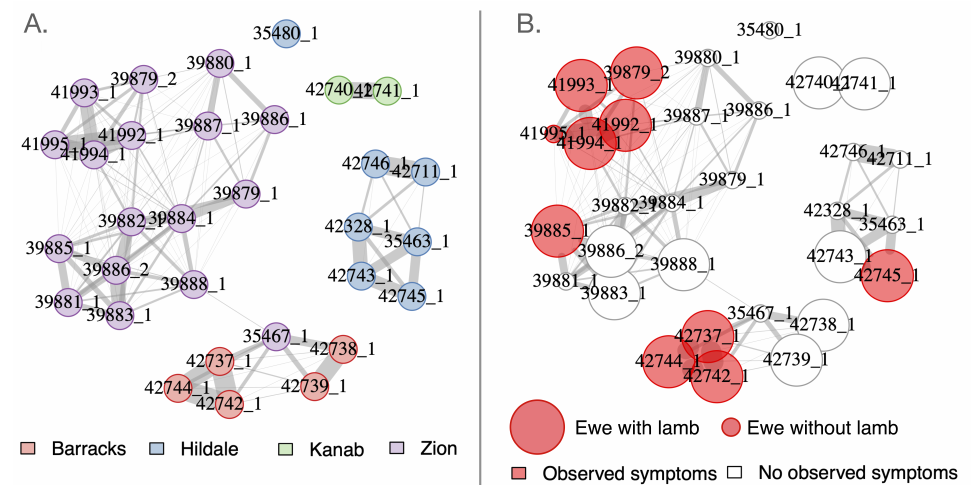
Figure 6. Ewe association network during the 2019 field study. The graph’s layout was determined using a Fruchterman–Reingold graph projection, which pulls nodes toward one another in proportion to the strength of association between the two individuals involved. ( A ) Social network with animal nodes colored according to their original release areas (“Zion” = within ZNP). ( B ) Social network with animal nodes colored according to whether or not they were observed in a group displaying pneumonia symptoms (red indicates animals that were observed with symptoms; white indicates animals that were never observed with